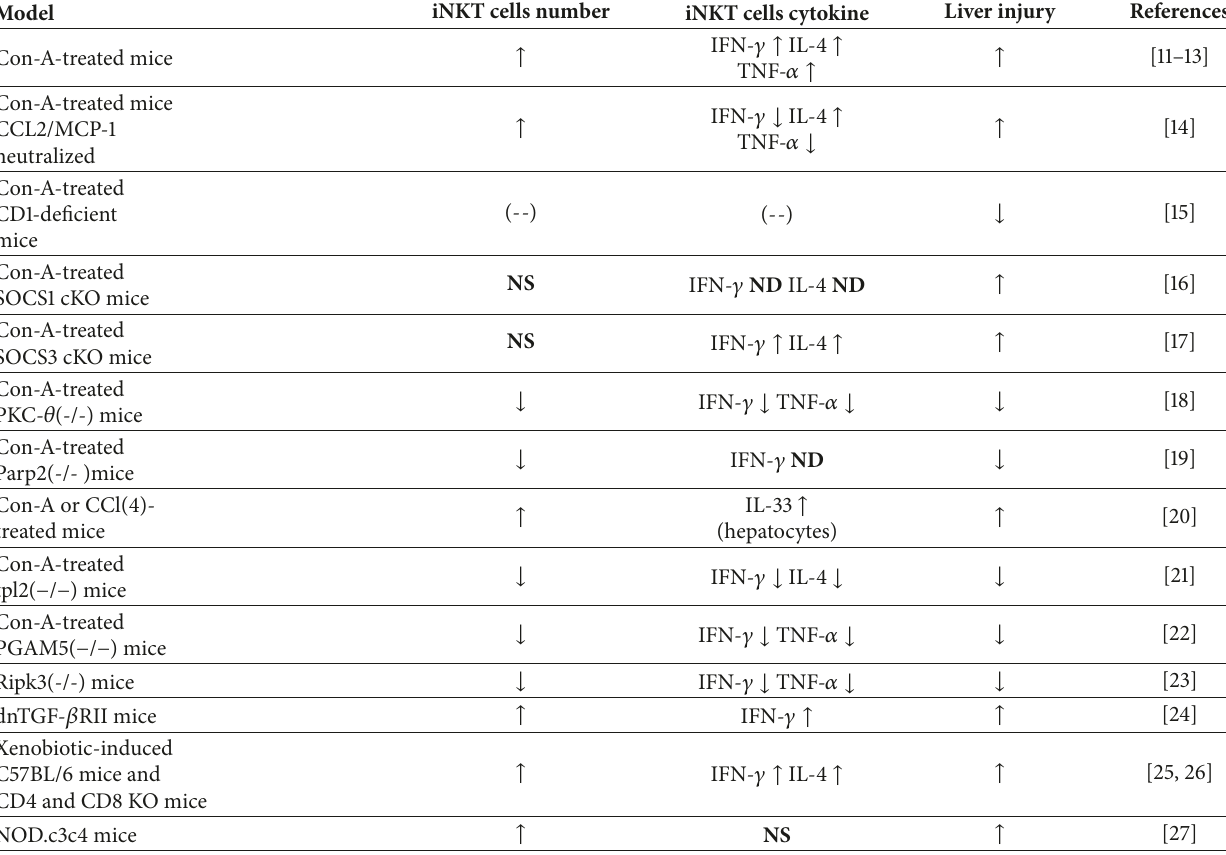
Table 1: Summary of studies in murine models supportive of a significant role of iNKT cells in the pathogenesis of AiLD.